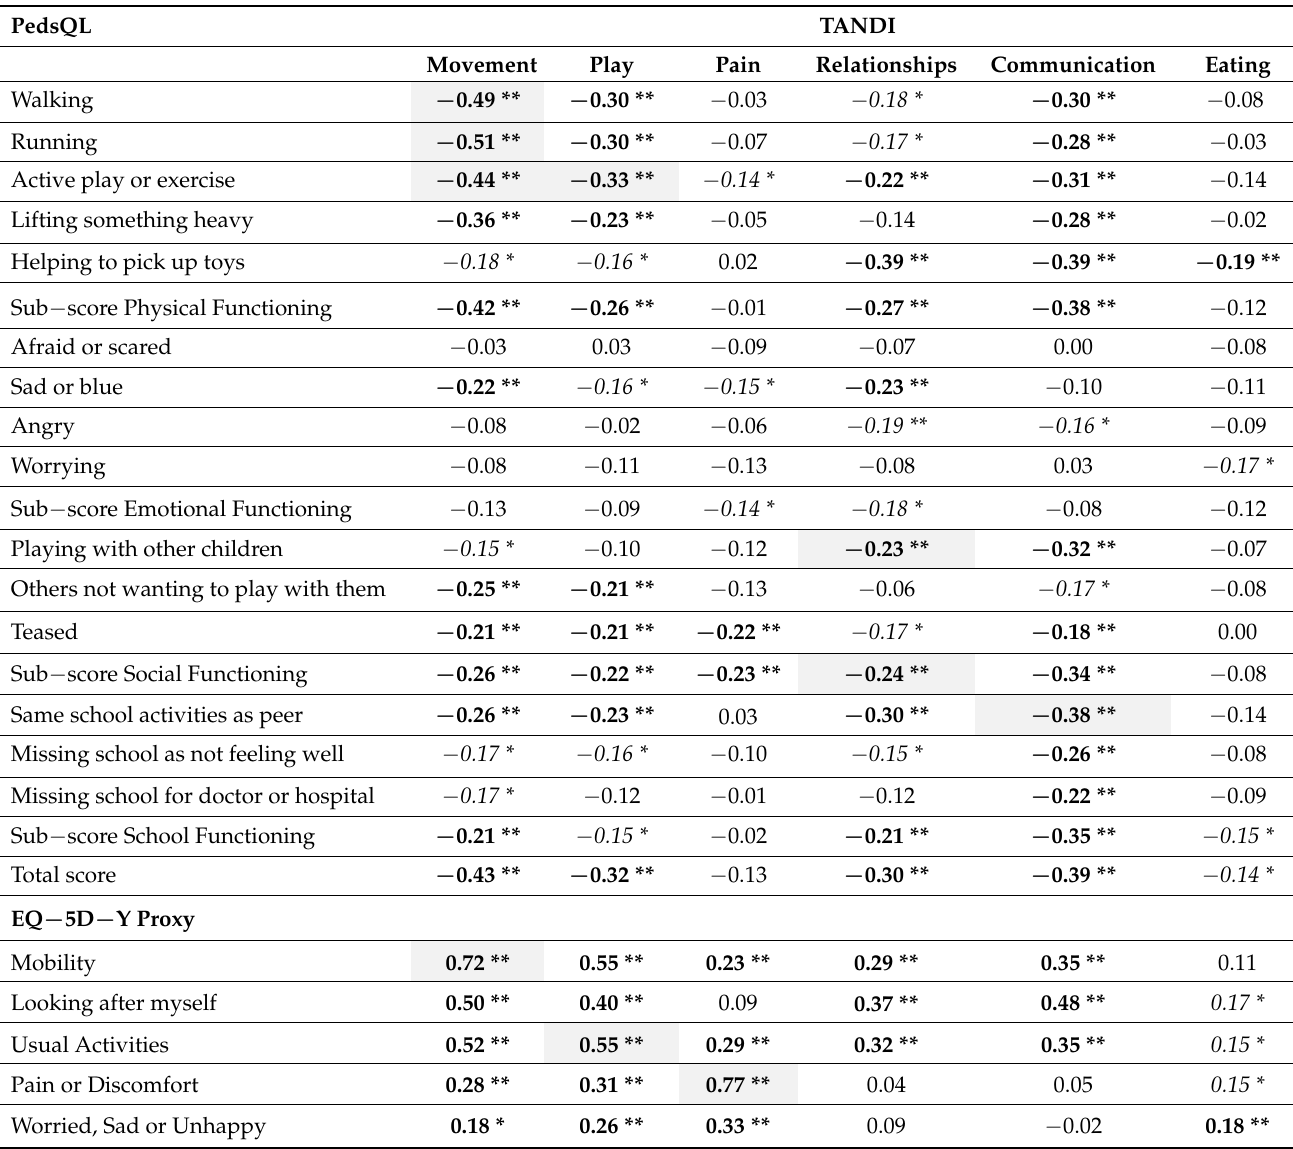
Table 3. Summary table of Spearman’s correlation of TANDI dimension versus PedsQL and EQ-5D-Y Proxy. (Total Sample N =